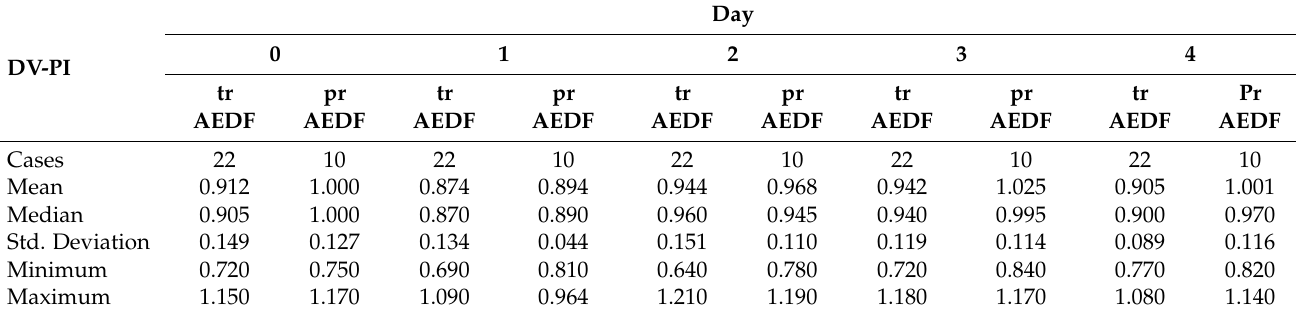
Table 6. The pulsatility index in ductus venosus (DV-PI), prior (day 0) and in the first 4 days after ma- ternal dexamethasone administration in the two groups. (tr/prAEDF = transiently restored/persistent absent end-diastolic flow in umbilical artery